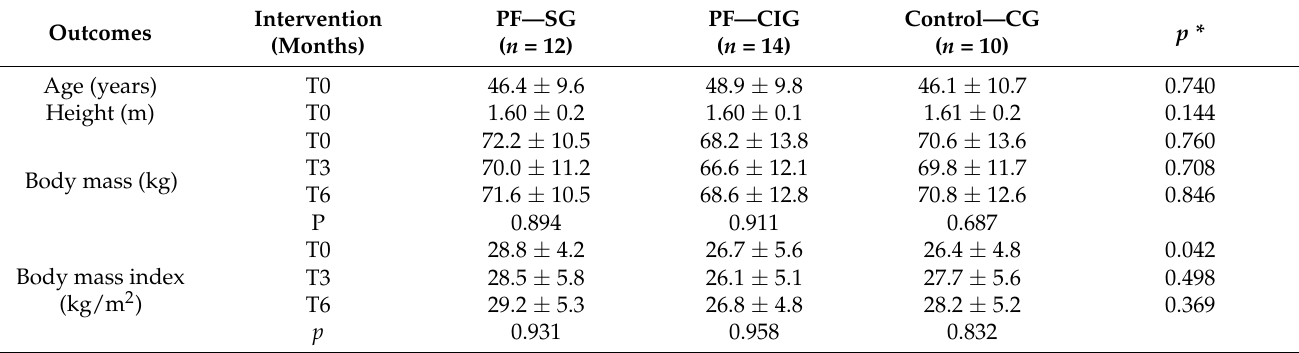
Table 1. Demographic and anthropometric data in the comparisons between women with plantar fasciitis (PF) and control (CG), for the different moments: baseline (T0) and after three (T3) and six months (T6) of intervention with the minimalist shoe (SG) and custom insole in the shoe